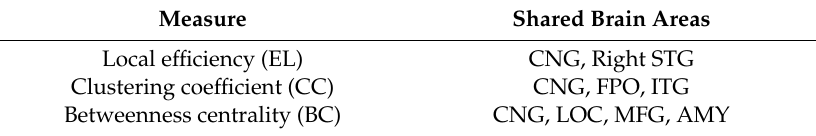
Table 5. Brain area for which significant correlations with clinical measures were found both in fathers and in their